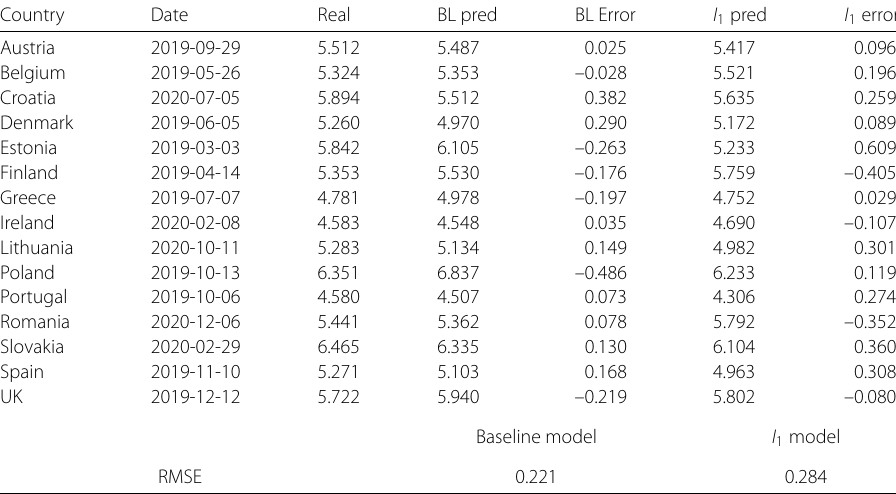
Table 4 Ideology Prediction results in 15 individual country elections Country